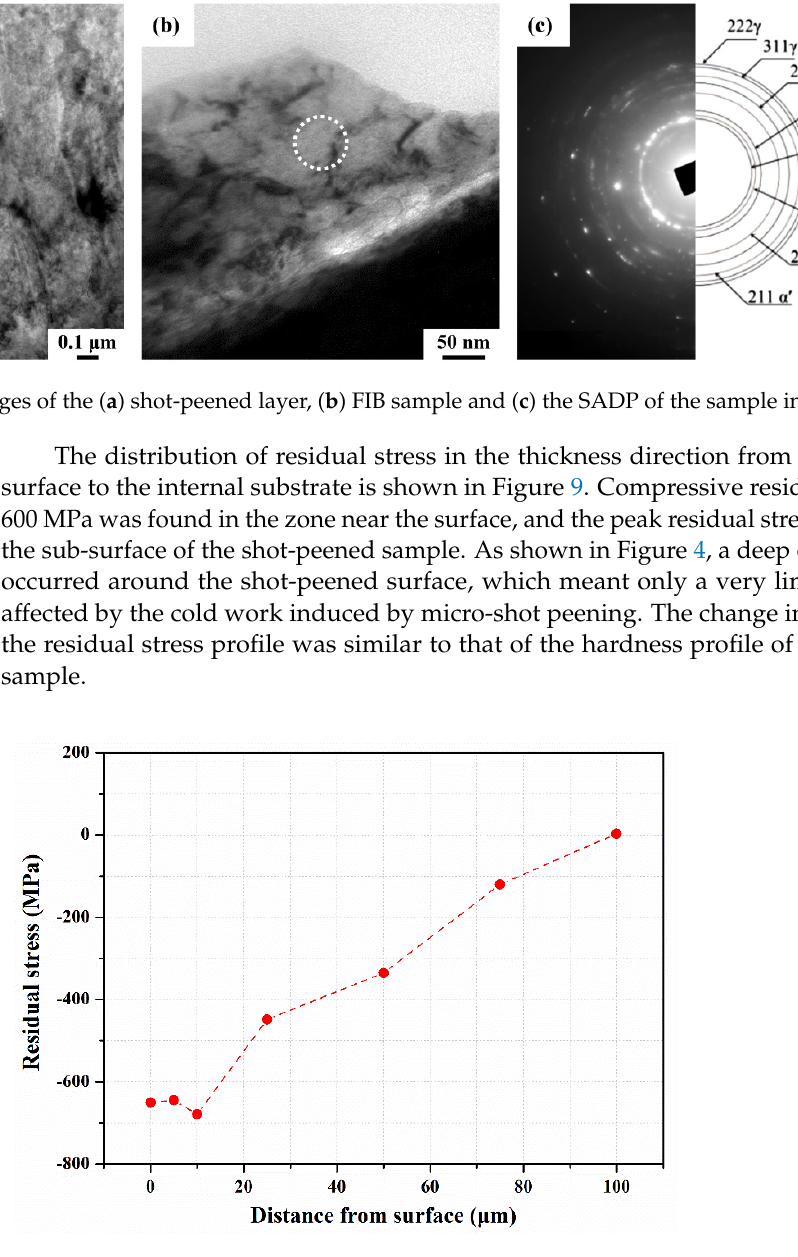
Figure 9. The residual stress profile from the shot-peened surface to the internal substrate. The results of tensile tests of the substrate showed that the yield strength, ultimate tensile strength and elongation of the substrate was 253 MPa, 621 MPa and 75%, respectively. Figure 10 presents the results of rotating bending fatigue tests conducted in air at room temperature for up to 10 7 cycles. The fatigue limit of the substrate was about 245 MPa, which was just a little lower than the yield strength of the substrate. Surface hardened layer was introduced in the shot-peened sample. The fatigue strength of the spot-peened sample over 5 × 10 6 cycles was about 265 MPa, which was obviously higher than the yield strength of the substrate. Moreover, the short fatigue life of the shot-peened sample emerged if the applied stress was over 270 MPa. The results indicated that the fatigue strength and life of the 304 SS could be improved by shot-peening, even if a very thin shot-peened layer was